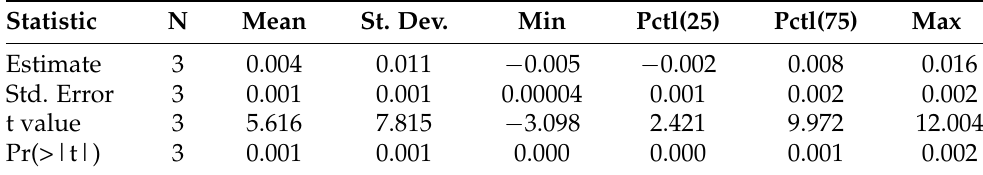
Table A2. Excess Mortality fit using GAM and autoregressive factors—parametric